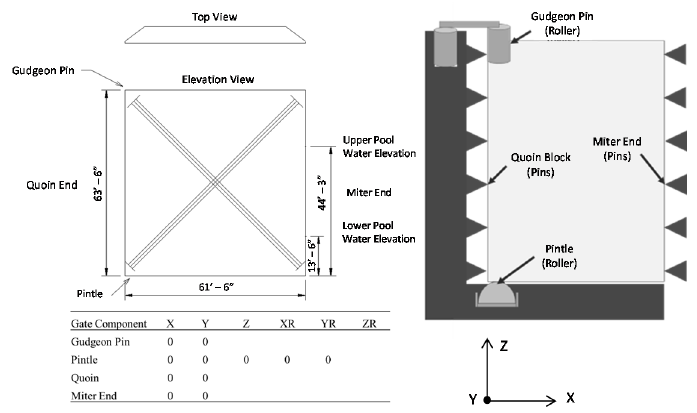
Figure 4. Lock gate: upstream elevation diagram and applied boundary conditions for one lock gate leaf.